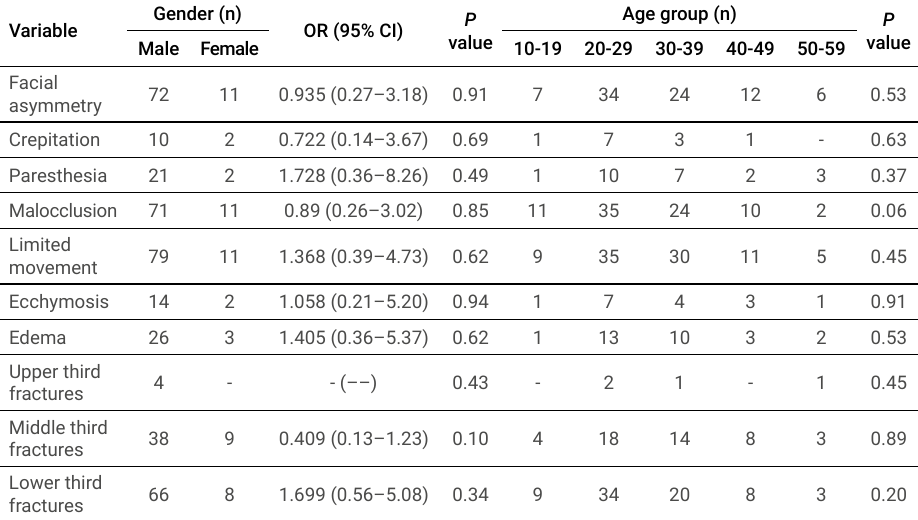
Table 1. Association between gender, age group and clinical features in maxillofacial trauma patients.